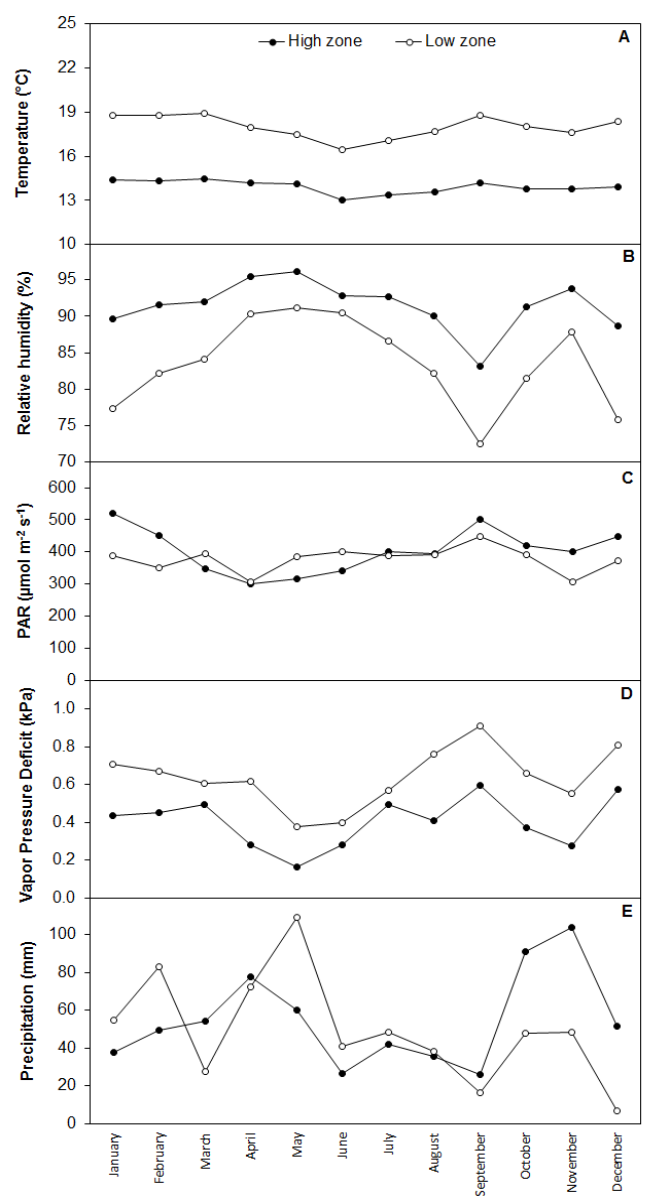
Fig. 1: Monthly behavior of climatic variables of the two cultivation areas in the municipality of Pasca (Cundinamarca, Colombia): high zone (2,498 m.a.s.l.), and low zone (2,006